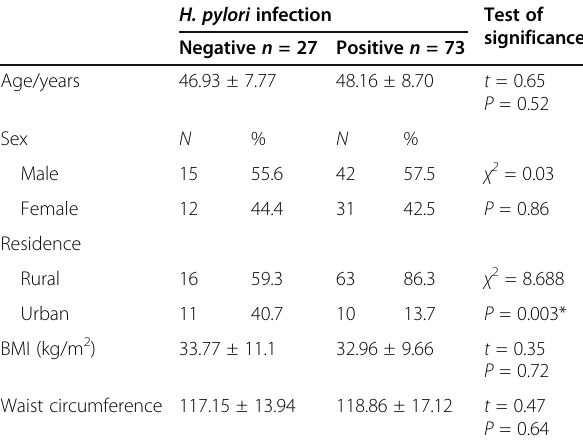
Table 5 Clinical characteristics of HP positive versus HP negative subjects in MET S with NAFLD group H. pylori